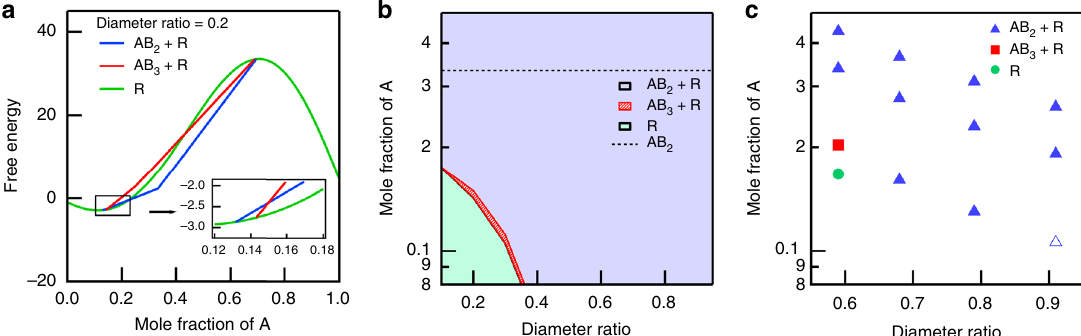
Fig. 8 Theoretical free energy calculations and phase diagram. a Free energies of three different phases (AB 2 +R phase ( blue ), AB 3 +R phase ( red ), and only R phase ( green )) for the diameter ratio of 0.2 as a function of the mole fraction of A. b Theoretical phase diagram obtained from a mean fi eld theory. Within the AB 2 +R phase region, the relative fraction of AB 2 and R phases varies with the mole fraction of A and the dotted line indicates the mole fraction of A (0.33) at which the pure AB 2 phase is formed without the R phase (Supplementary Fig. 6). c Experimental phase diagram determined from the SAXS intensities. At the diameter ratio of 0.91 and the mole fraction of A of 0.11 (an un fi lled triangle in c ), AB 2 +R phase is expected from the theory. However, new SAXS peaks corresponding to AB 2 superlattice were not observed. This may indicate that the fraction of AB 2 superlattce is very low at this point. The variation of integrated intensities of new peaks corresponding to AB 2 superlattice with the more fraction of A is given in Supplementary Fig.